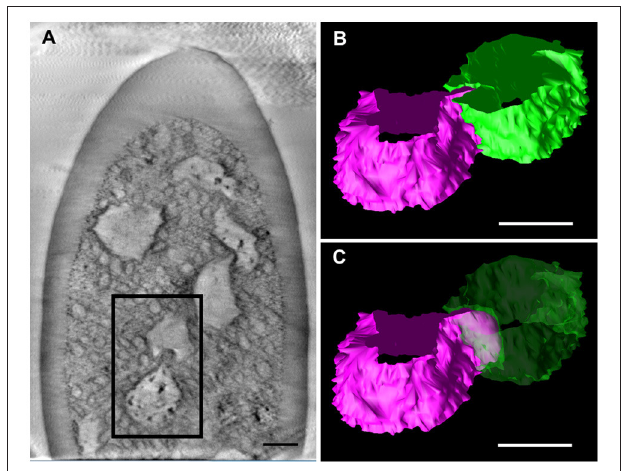
FIGURE 3 | Tomographic analysis of beaded-structures in a Sensilla basiconica . (A) A tomographic slice image of 3.4 nm-thick in an S. Basiconica of C. japonicus worker. (B) 3D tomographic models of two adjacent beads, surface of which are colored in magenta and green, in a square of (A) . (C) Same as (B) , but one bead surface is shown as translucent green. Bars indicate